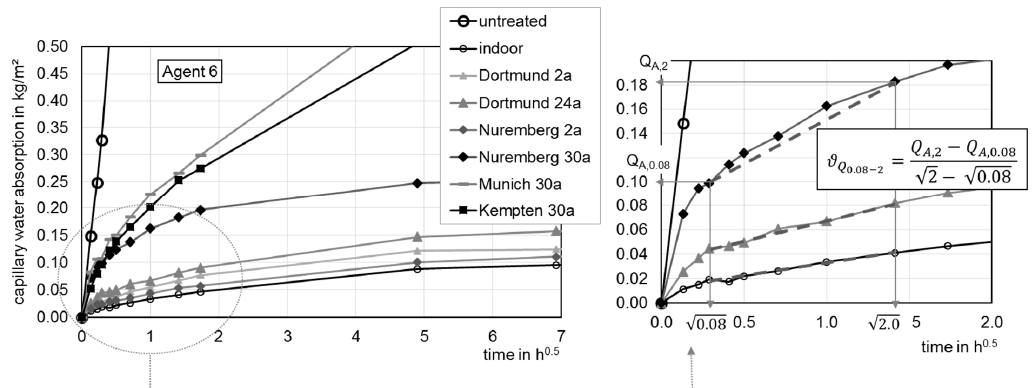
Figure 3. Evaluation of the capillary water absorption with regard to the velocity of water uptake